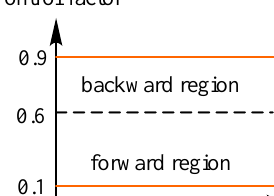
Figure 4. Variation of probability of the interference factor, 𝑠𝑖𝑔𝑛 = 1 .